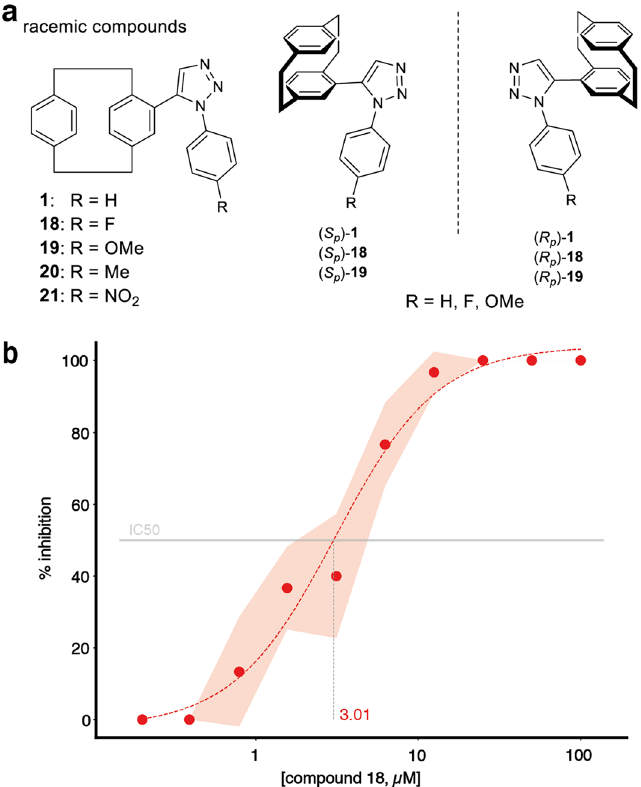
Figure 6. ( a ) Racemic lead structure 1 and structures of the 5-([2.2]paracyclophan-4-yl)-1-aryl-1,2,3-triazoles in their ( S p )- and ( R p )-configuration. The compounds were synthesized with different residues R: racemic compounds with R = H, F, OMe, Me, and NO 2 , S p and R p -compounds with R = H, F and OMe each. Details on the structures and results can be retrieved from Supplementary File 1 online. ( b ) Dose–response study of racemic compound 18. Animals were treated in triplicates with the indicated concentration of the compound for 30 min. Nematocyst discharge was recorded by counting the fraction of artemia (out of ten) caught by each polyp after 15 min. The compound concentration is shown in the log scale. Colored areas correspond to standard deviation. IC50 values were determined by fitting logistic functions to the average inhibition (dashed lines) and solving them for 50%